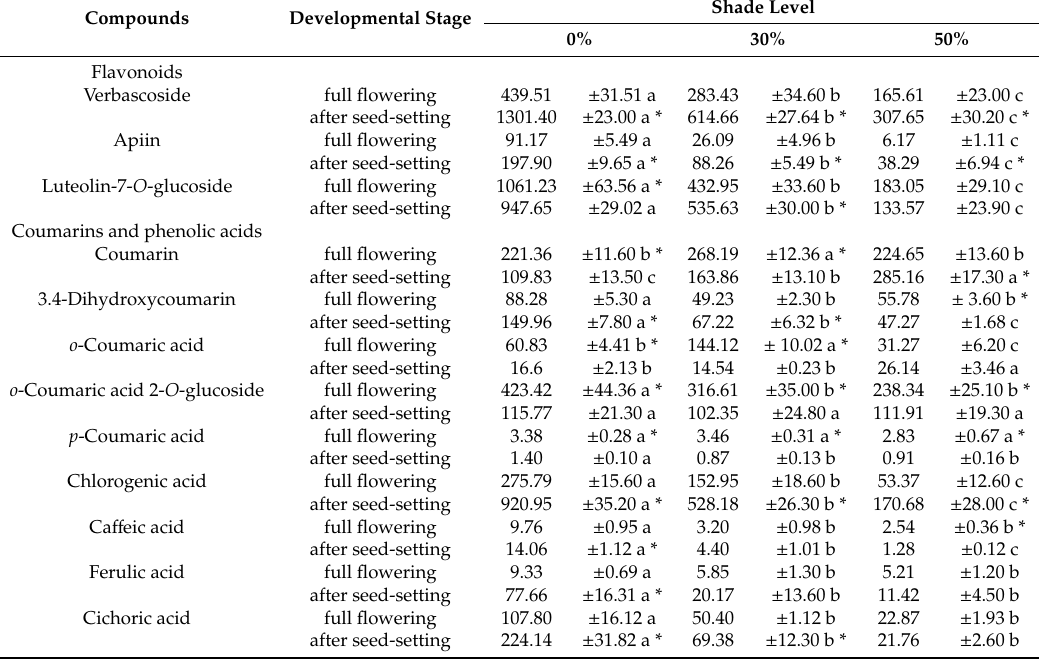
920.95 ±35.20 a * 528.18 ±26.30 b * 170.68 ±28.00 c *